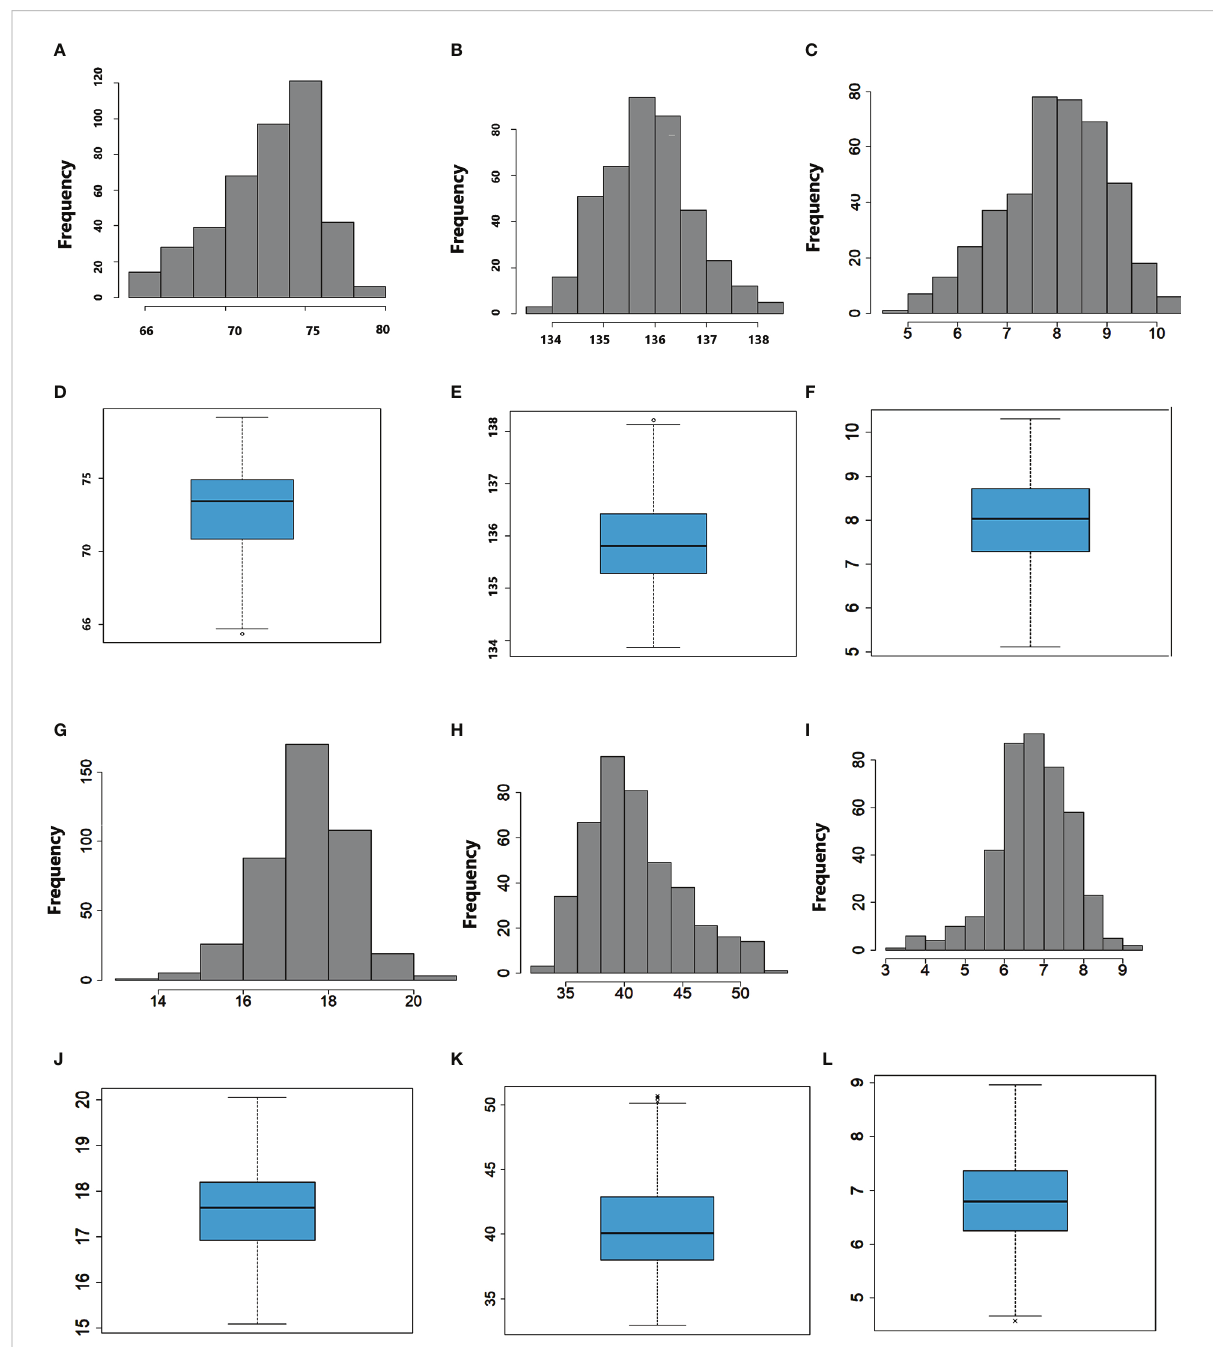
FIGURE 1 Frequency distribution and boxplots of DTH (A, D) , DTM (B, E) , SPL (C, F) , SPP (G, J) , TKW (H, K) , and GYD (I, L)